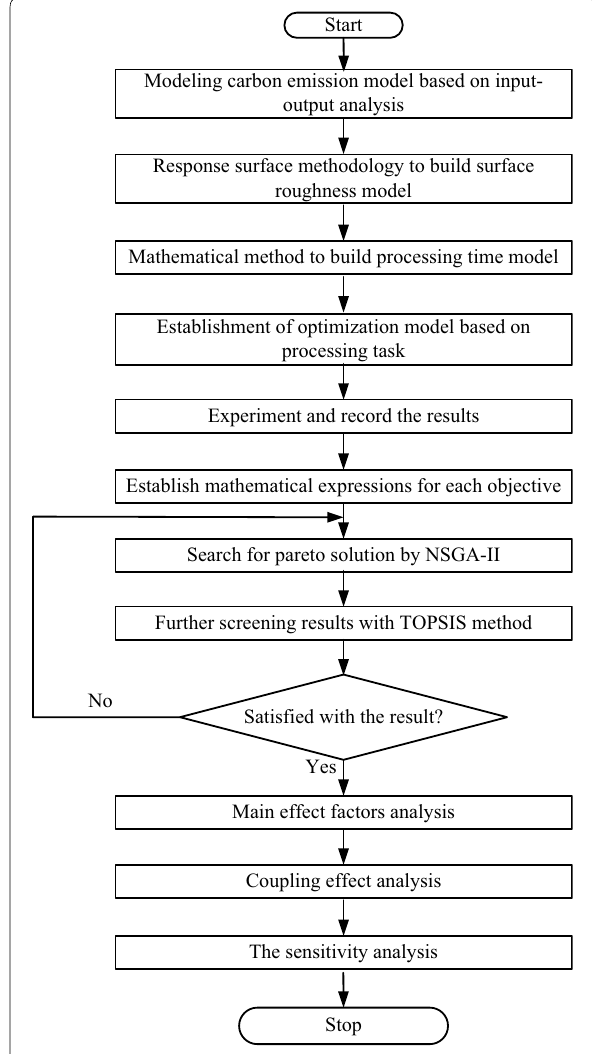
Figure 1 Flow chart of the present